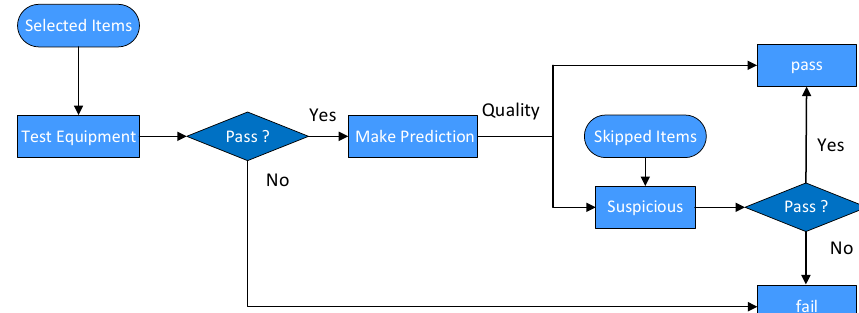
Figure 2. The test flow for the test chips.